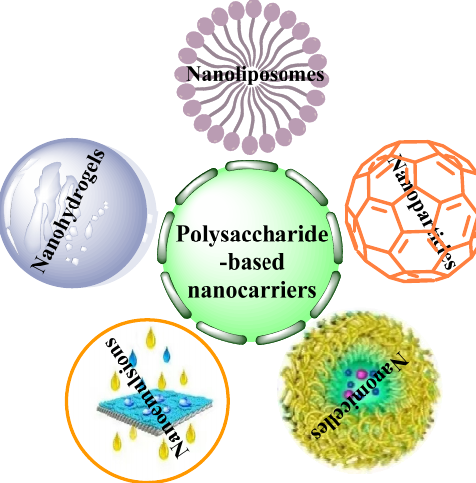
Figure 9. Polysaccharide-based